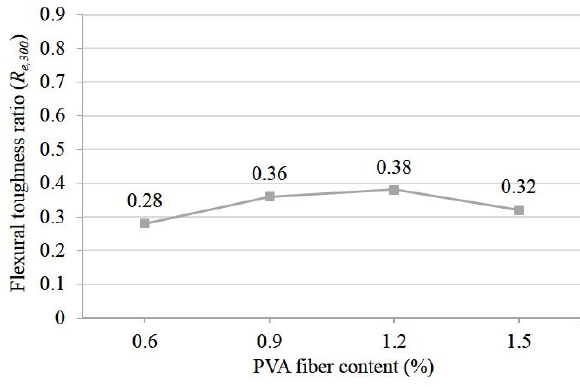
Figure 11: Flexural toughness ratio ( R e ,500 ) of NS composites with